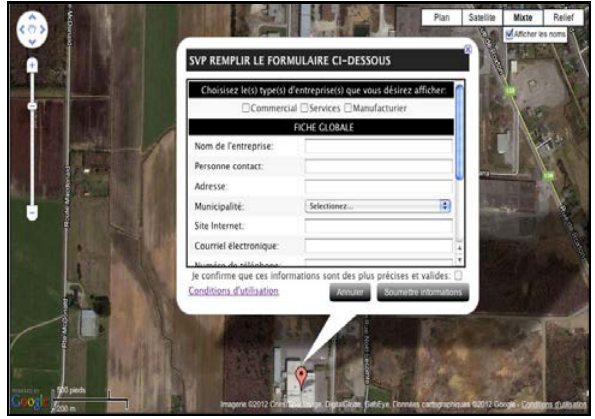
Figure 2: GeoActon interface for users to add and edit information (Source: Beaudreau et al., 2012)